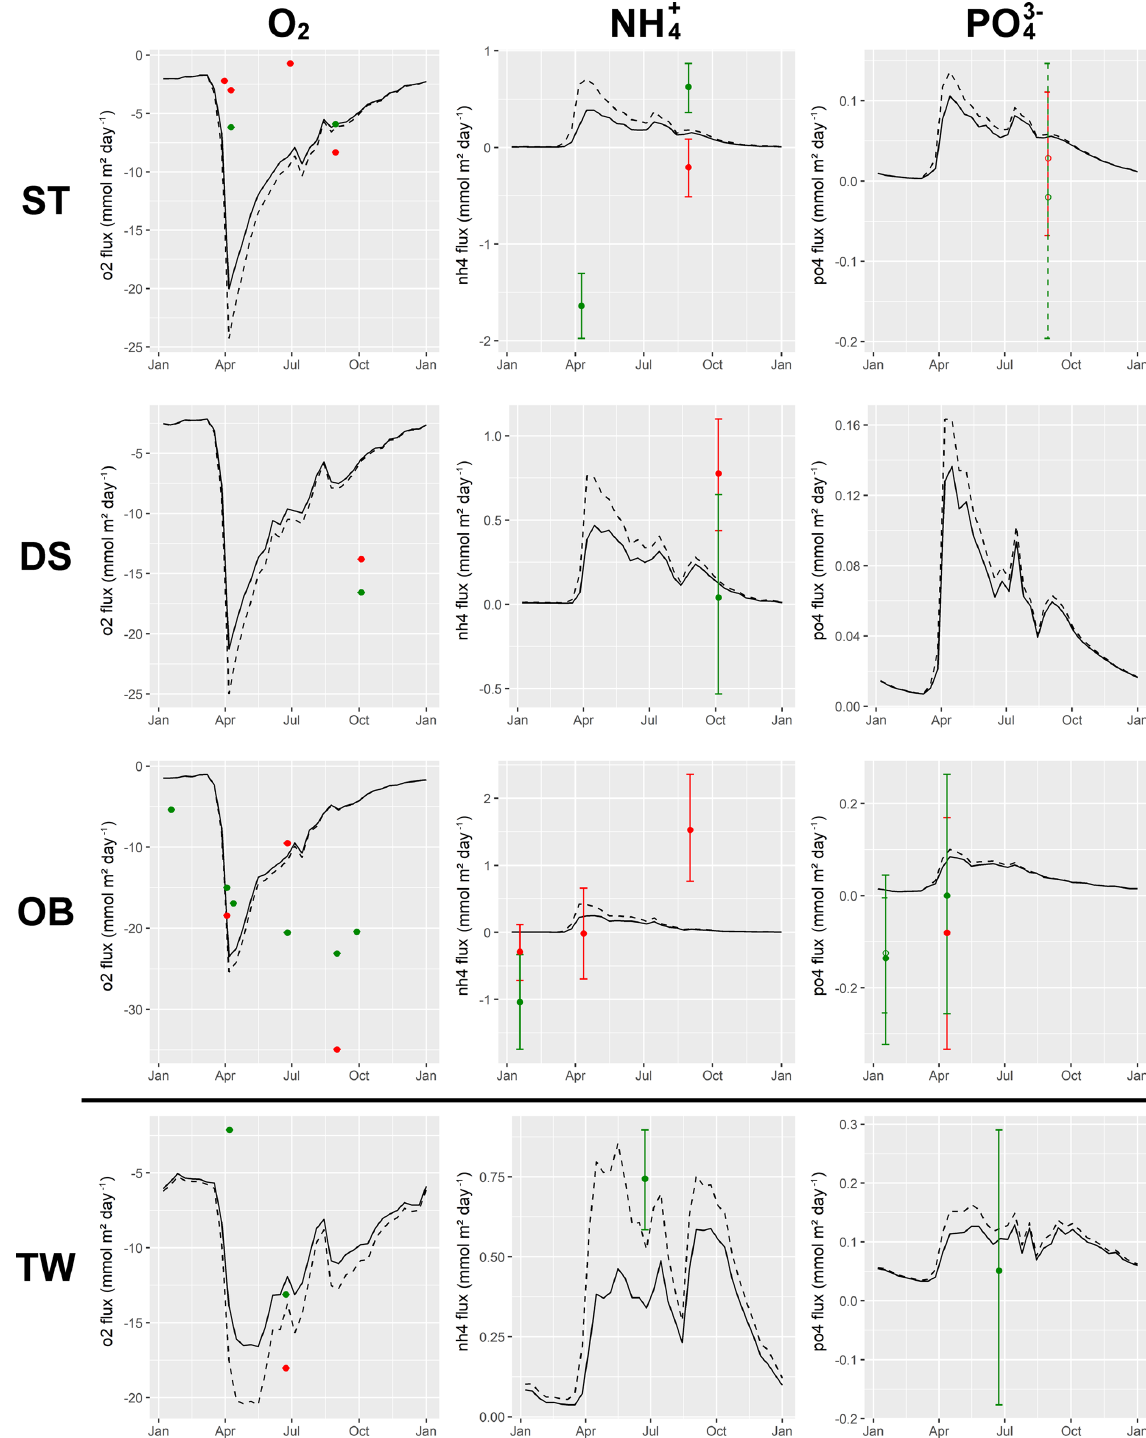
Figure 10. Fluxes between the sediment and bottom water of selected pore water species at sand stations. Positive values denote fluxes out of the sediment. Solid line: modelled fluxes between sediment and bottom water only. Dashed line: fluxes including mineralisation of the fluff layer material. Dots: measured fluxes by two benthic chambers (BC1 in red and BC2 in green). Vertical ranges: uncertainties of these fluxes estimated by a bootstrapping method. For phosphate: full circles are estimates based on phosphate determination by photometric methods, and open circles are estimates based on P quantification by the ICP-OES